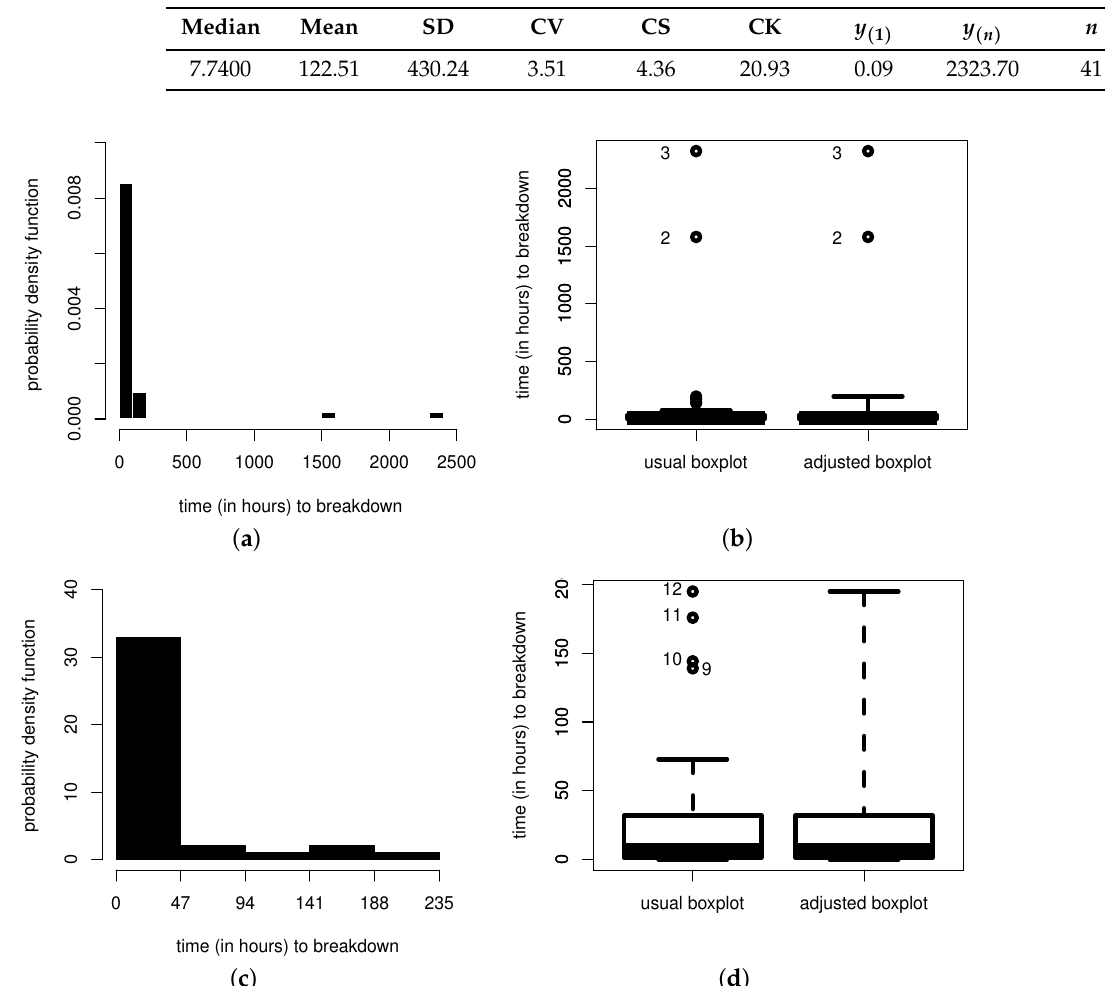
Table 1. Descriptive statistics for the data of times to electrical breakdown (in hours).